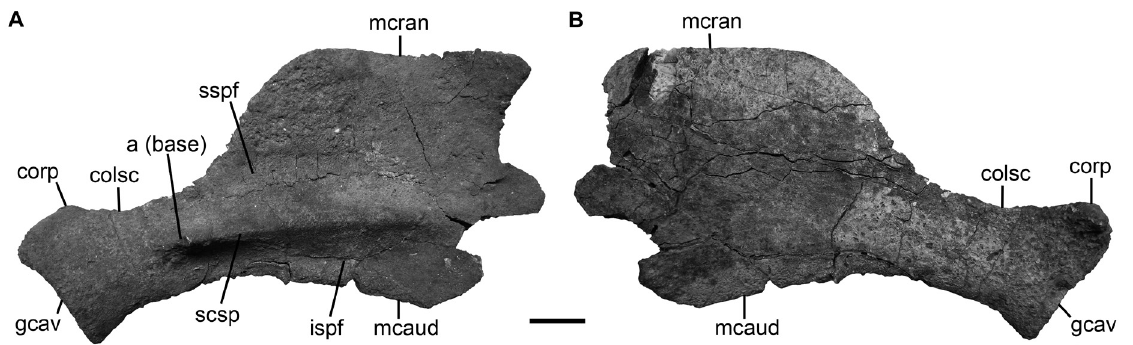
Fig. 10. Left scapula of Lentiarenium cristolii ( Fitzinger, 1842) (OLL 1854/327). A . In lateral view. B . In medial view. Scale bar = 2